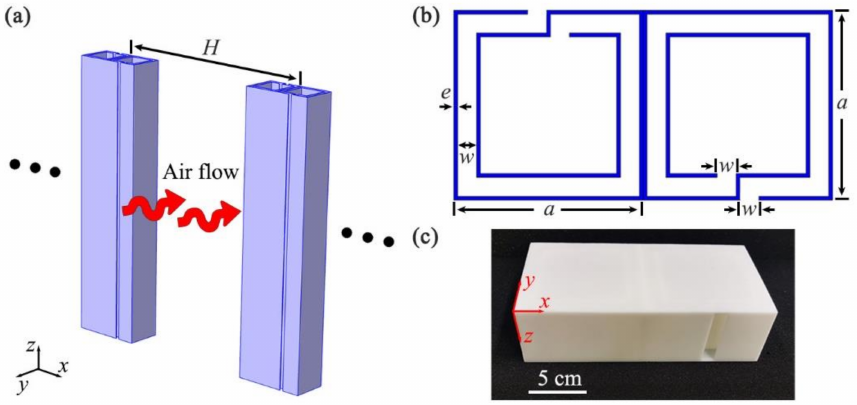
Figure 1. ( a ) Schematic of an open, sound-insulation barrier; ( b ) cross-sectional view of a unit; ( c ) a photograph of the